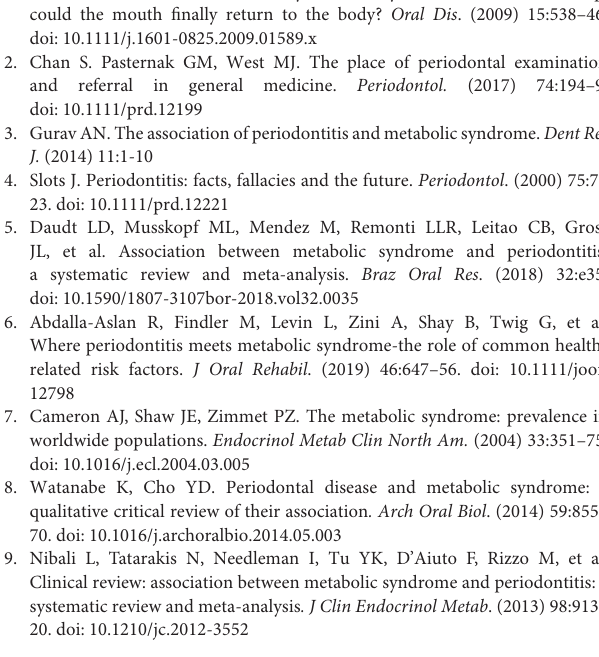
Supplementary Table 1 | Newcastle-Ottawa quality assessment